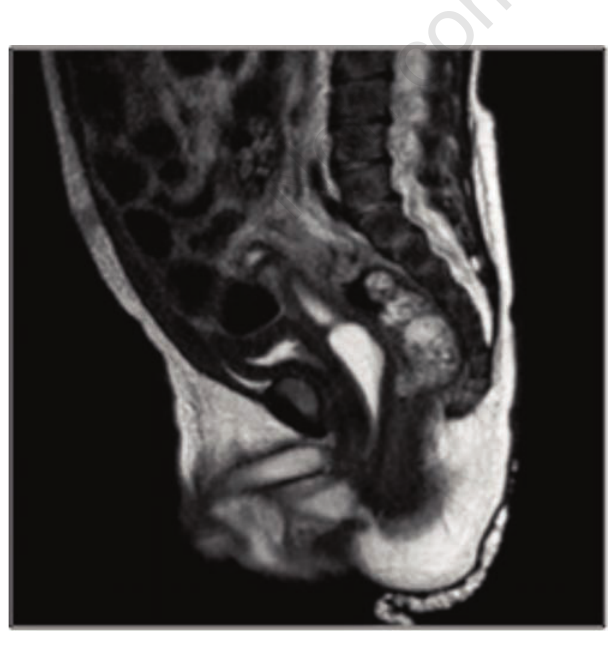
Figure 1. Sagittal image of pre-operative magnetic resonance imaging.